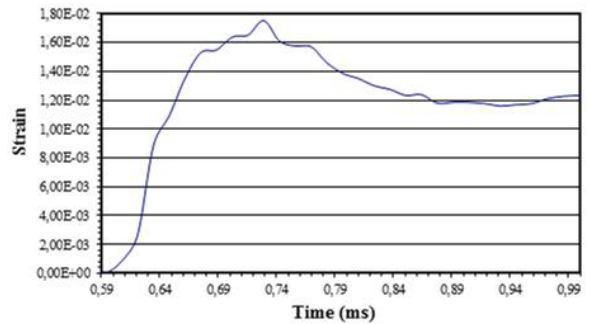
Figure 14. Strain-time curve in the centre of the SiC-reinforced ZC71 magnesium alloy specimen pertinent to the modified SHTB including an interruption device (Model 3) when using 0.8mm thick lead damping rings at − 5000mms − 1 .